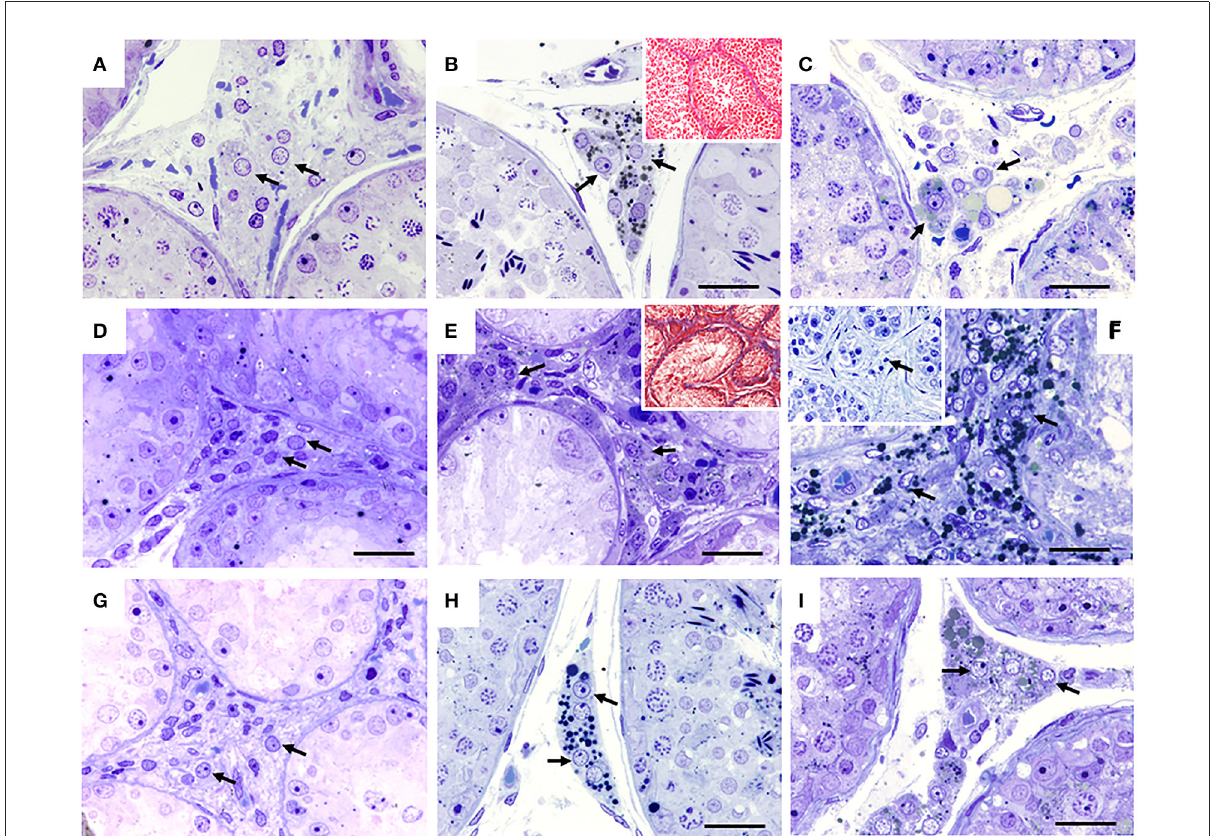
FIGURE4 Seminiferous tubules of dogs from the control (CTRL) (A–C) , cryptorchid (CO) (D–F) and contralateral (CONTRA) (G–I) groups at peripubertal (first column); young adult (second column) and senile (third column) stages. The interstitial spaces with their characteristic Leydig cells (arrow) are observed. The young adult and senile stage CO group showed small Leydig cell hyperplasia, when compared with the other groups. In some cases in the CO group in the senile stage, completely degenerated seminiferous tubes can be seen with some degenerating or absent Leydig cells ( F insert). Toluidine Blue, except (B,C) Masson trichrome technique. Bar scale: 50 µ